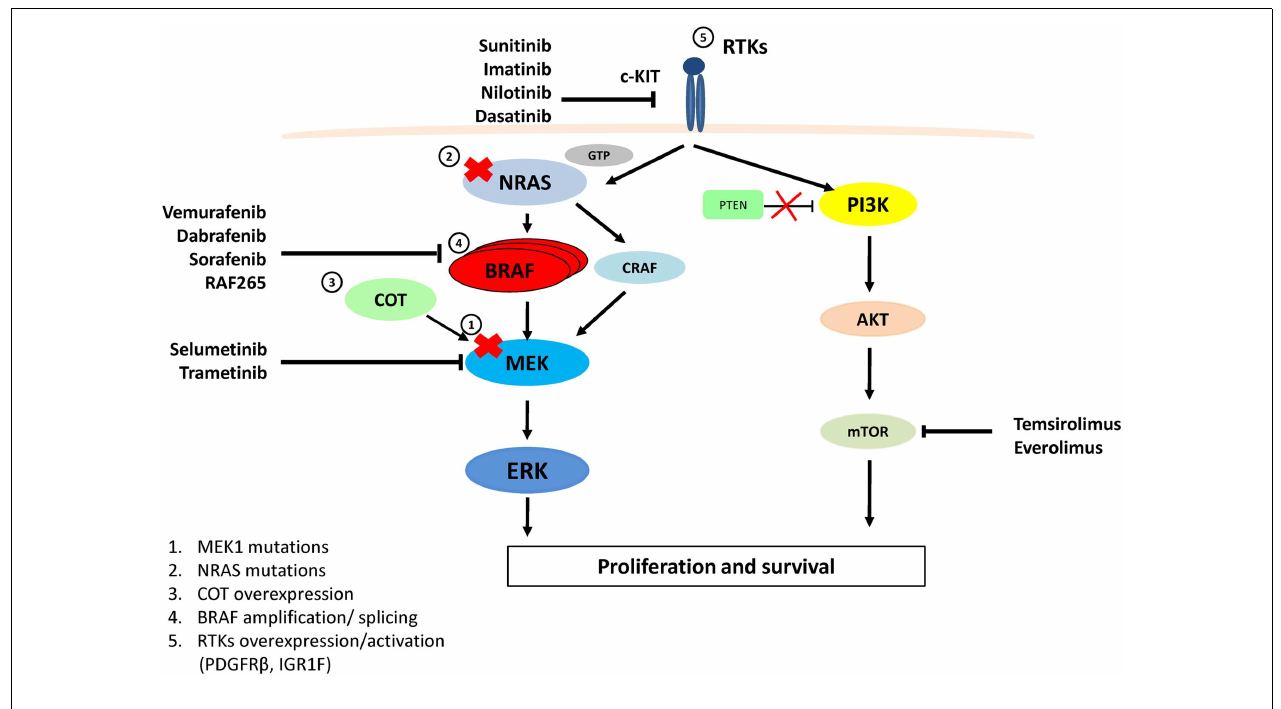
from MAPK pathway reactivation by (1) a MEK1 C121S mutation, (2) NRAS Q61R/K mutations, (3) COT1 overexpression, (4) alternatively spliced variants of BRAF V600E or amplification of the mutant BRAF allele, (5) Overexpression or activation of RTKs (PDGFR β or IGF1R) bypasses mutant BRAF and activates ERK via CRAF-MEK or through independent ERK mechanisms by activating the PI3K/AKT